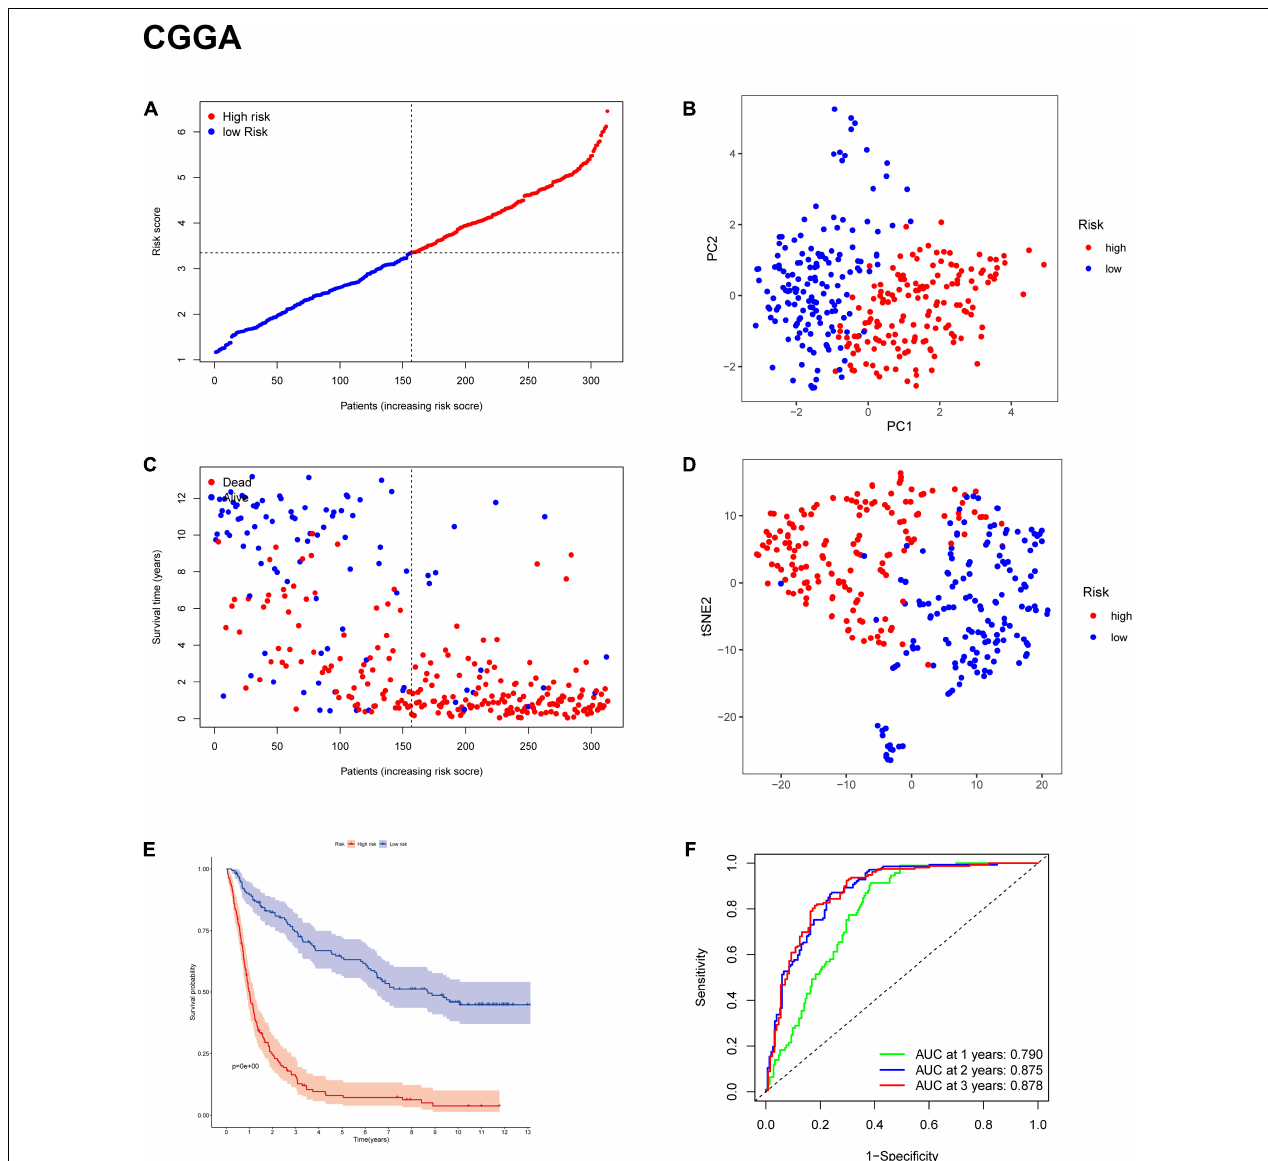
FIGURE 4 | Prognostic validation of the 11-gene signature in the CGGA cohort. (A,C) Distribution and median value of risk scores in the CGGA cohort. (B) PCA plot of the CGGA cohort. (D) t-SNE analysis of the CGGA cohort. (E) Kaplan-Meier survival curve for the OS of patients in the high-risk group (red line) and low-risk group (blue line) in the CGGA cohort. (F) AUC of time-dependent ROC curve analysis in the CGGA cohort.